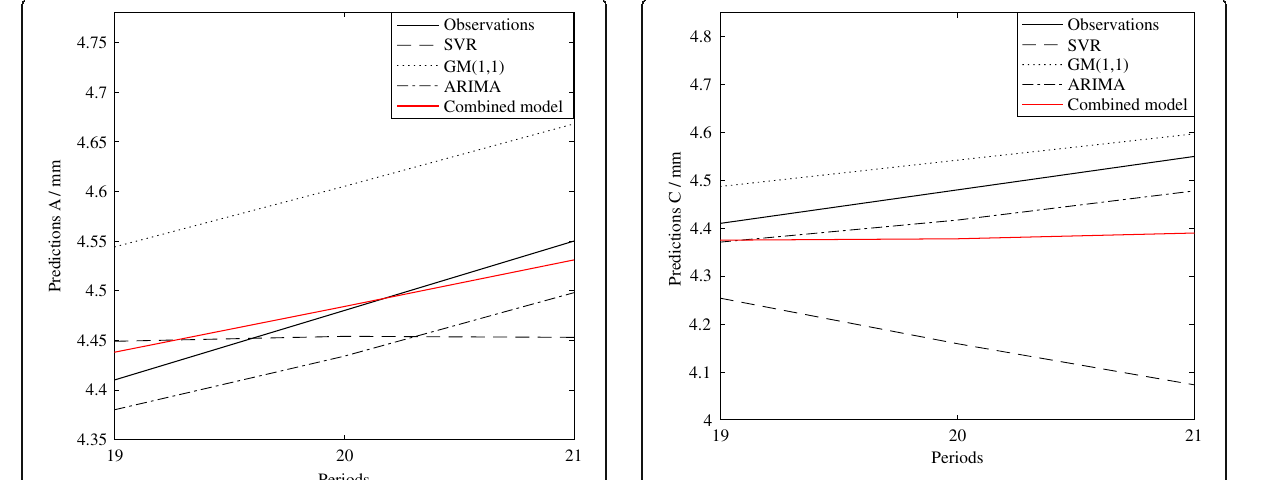
Fig. 5 Predictions C of each model. Predictive value C is predicted by three single models when the fitting data is slightly disturbed (fifth and tenth observations were adjusted to 4 and 4 mm respectively). According to the predictions C of single model and combined model, and the observations, we connect the respective values through the broken line, which can form the most direct contrast